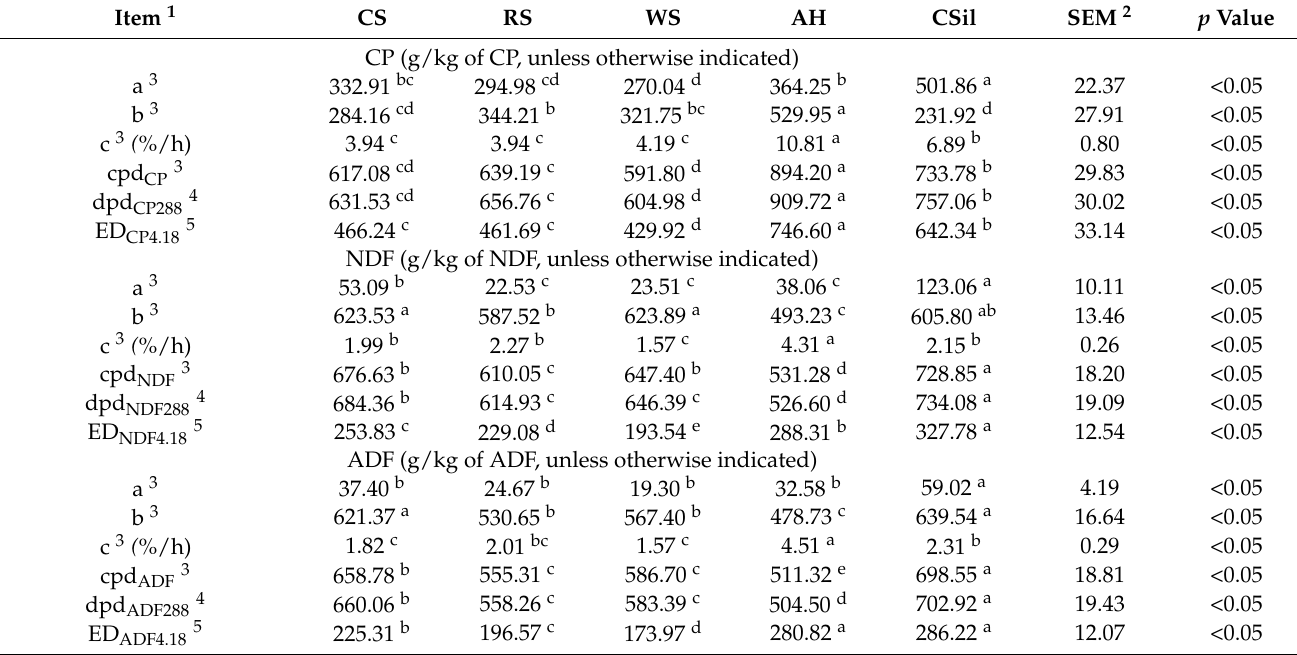
Table 2. In situ ruminal degradation kinetics and effective degradability of CP, NDF, and ADF in different forages ( n =